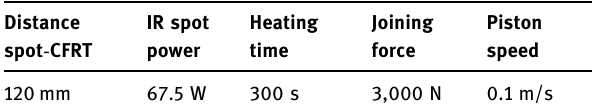
Table 2: Heating and joining